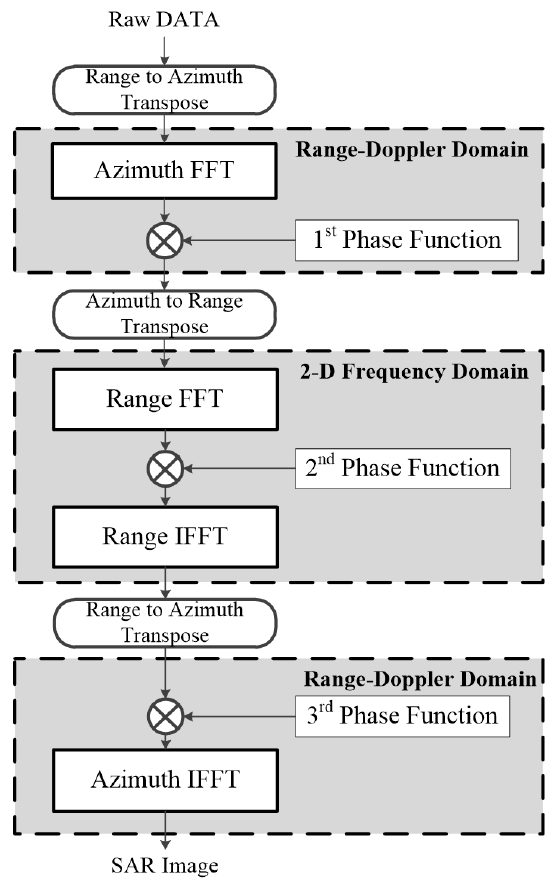
Figure 2. Traditional CSA